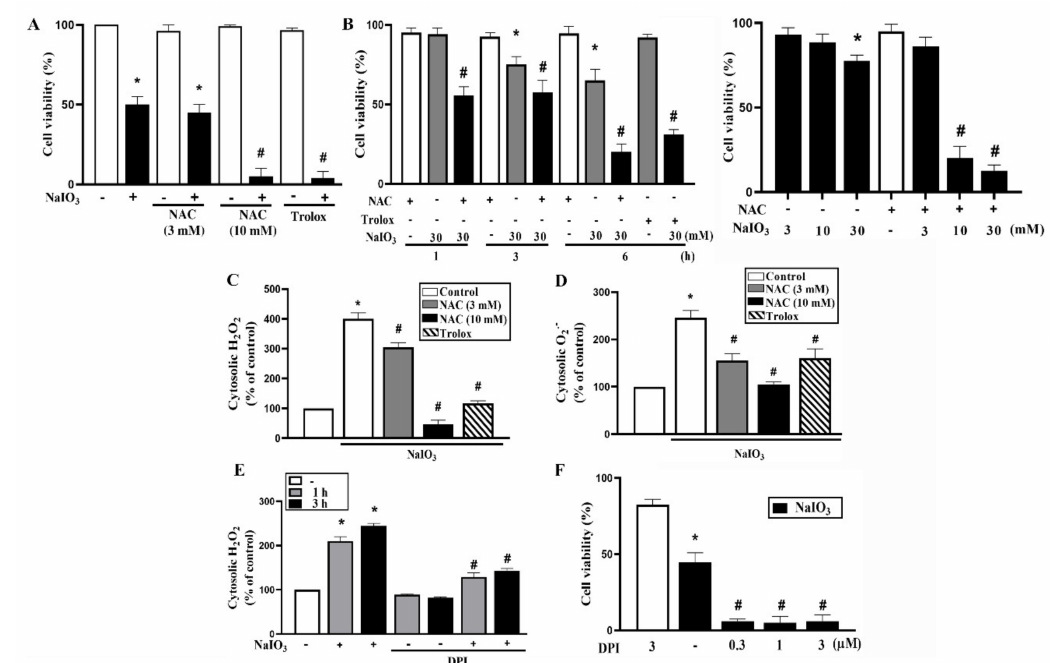
Figure 1. NaIO 3 -induced cell death is enhanced by antioxidants N-acetyl cysteine (NAC) and trolox. ( A ) Cells were pretreated with NAC (3 mM, 10 mM) 20 min prior to NaIO 3 (30 mM) for 18 h. ( B ) Cells were pretreated with NAC (10 mM), trolox (500 µ M) 20 min prior to NaIO 3 stimulation for indicated time points (left panel) or 6 h (right panel). Cell viability was determined by Annexin V / PI staining using flow cytometry. ( C , D ) After pre-treatment with antioxidants followed by NaIO 3 (30 mM) for 6 h, cytosolic H 2 O 2 ( C ) and cytosolic O 2 − ( D ) were measured by using DCFDA and DHE, respectively. ( E ) After pretreatment with DPI (3 µ M) 20 min prior to NaIO 3 (30 mM) for indicated time points, cytosolic H 2 O 2 was determined. ( F ) Cell viability was determined after cells were pretreated with DPI followed by NaIO 3 (30 mM) for 18 h. Data were mean ± SEM from three independent experiments. * p < 0.05, indicating the significant e ff ect of NaIO 3 . # p < 0.05, indicating the significant enhancement e ff ects of NAC, trolox and DPI on the response of NaIO 3